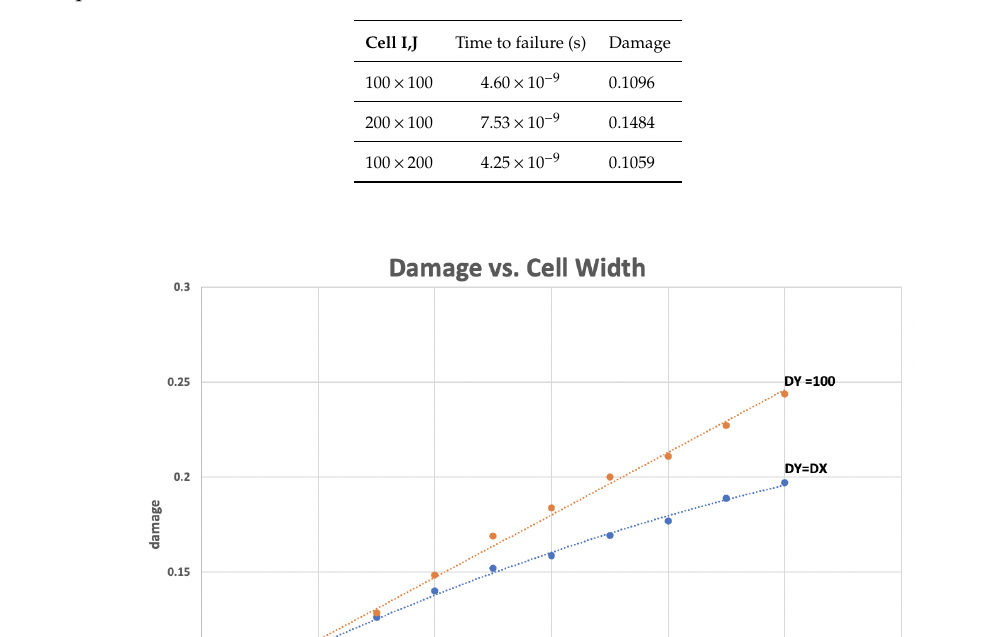
Table 3. Doubling the width of the statistical crack model ( time to failure and damage at failure. Doubling the height of the both quantities.